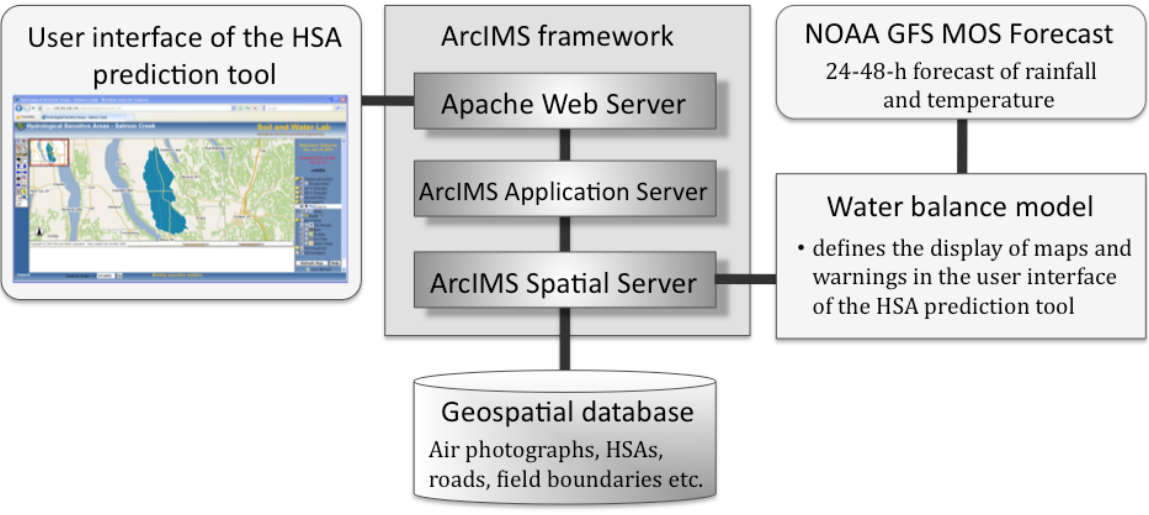
Figure 1. Integrated system components of the hydrologically sensitive area (HSA) prediction